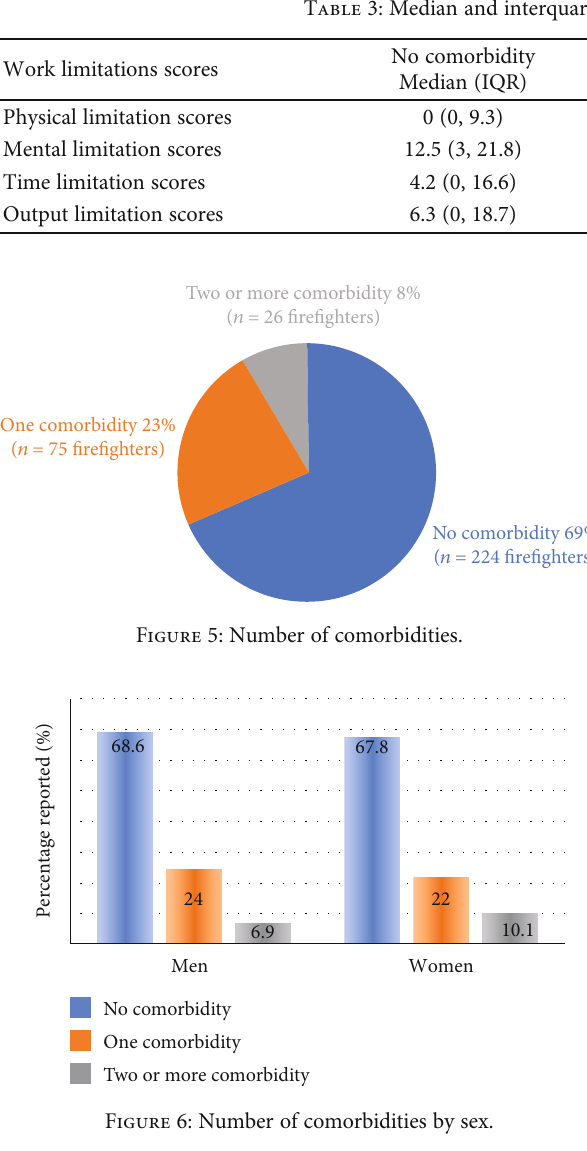
women FFs with upper extremity pain ( p = 0 : 05 ) and women FFs without pain.